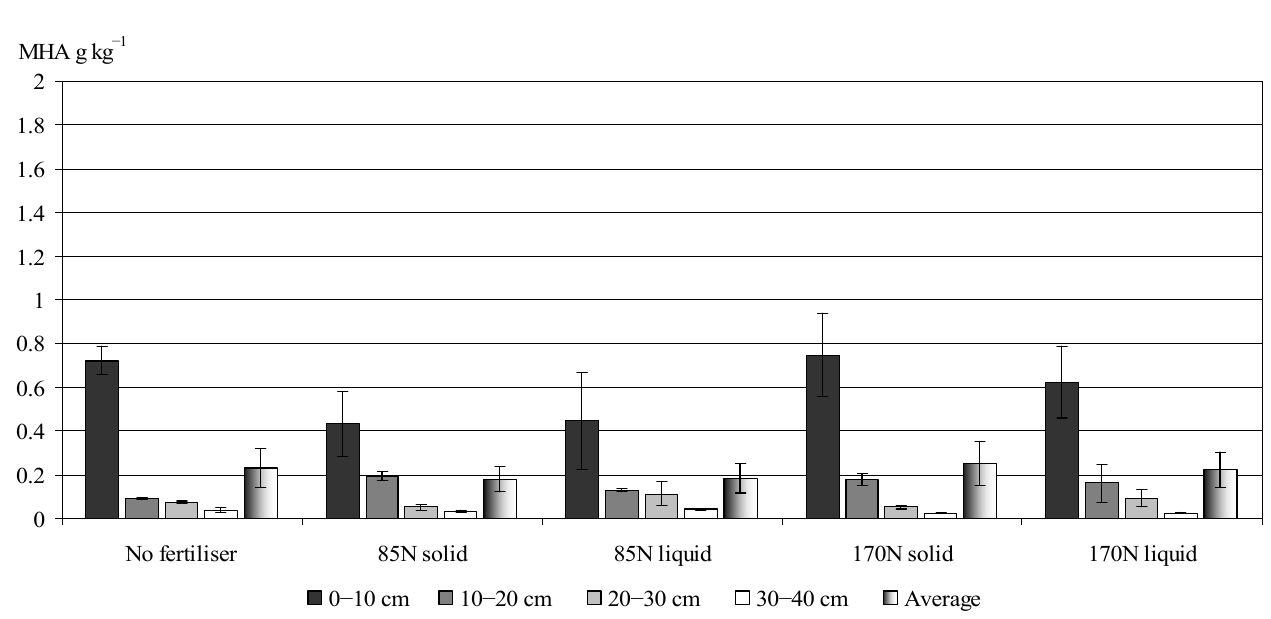
Figure 18. MHS content in grassland in Retisol, 2020.